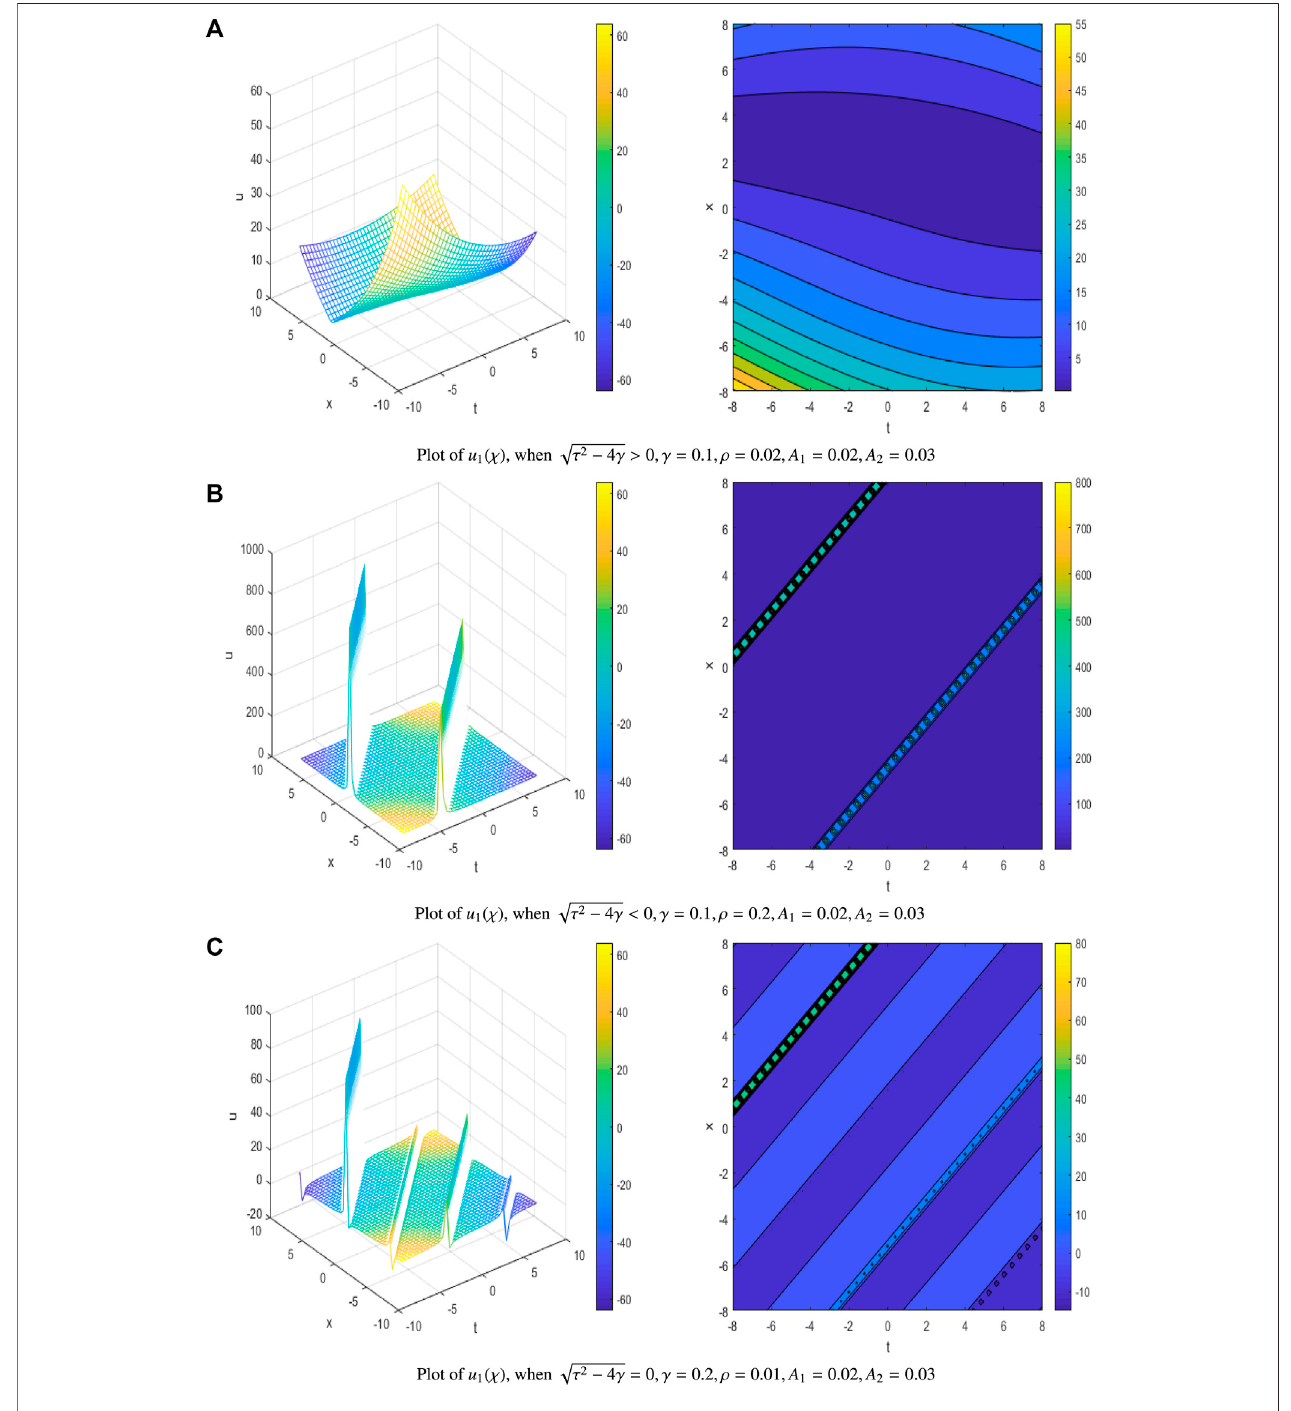
FIGURE 2 | Traveling wave solution corresponding to the Zakharov Kuznetsov equation (ZK) equation. (A) Plot of u A 1 (cid:2) 0 . 02 , A 2 (cid:2) 0 . 03. (B) Plotof u 1 ( χ ),when